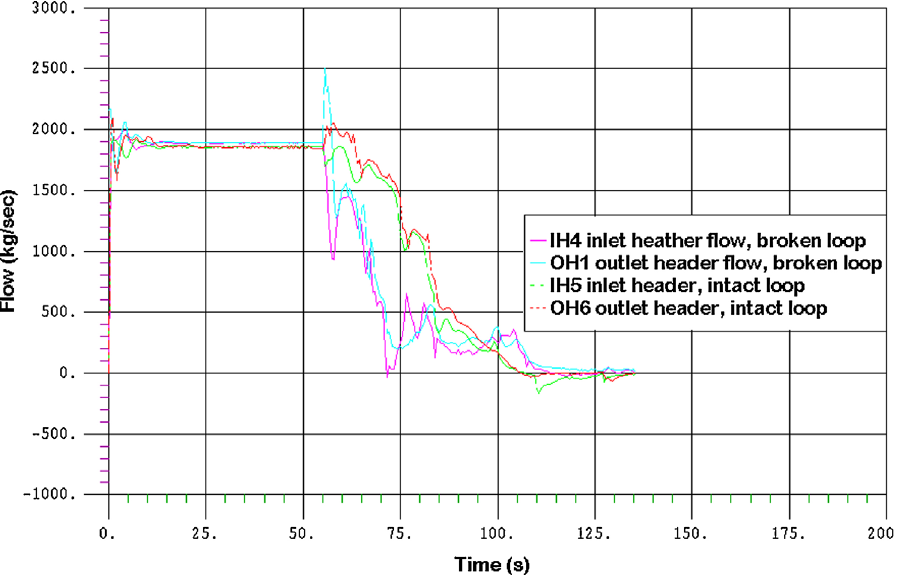
Fig. 2. Flow variation in LOCA accident with 100% break of inlet header [1].